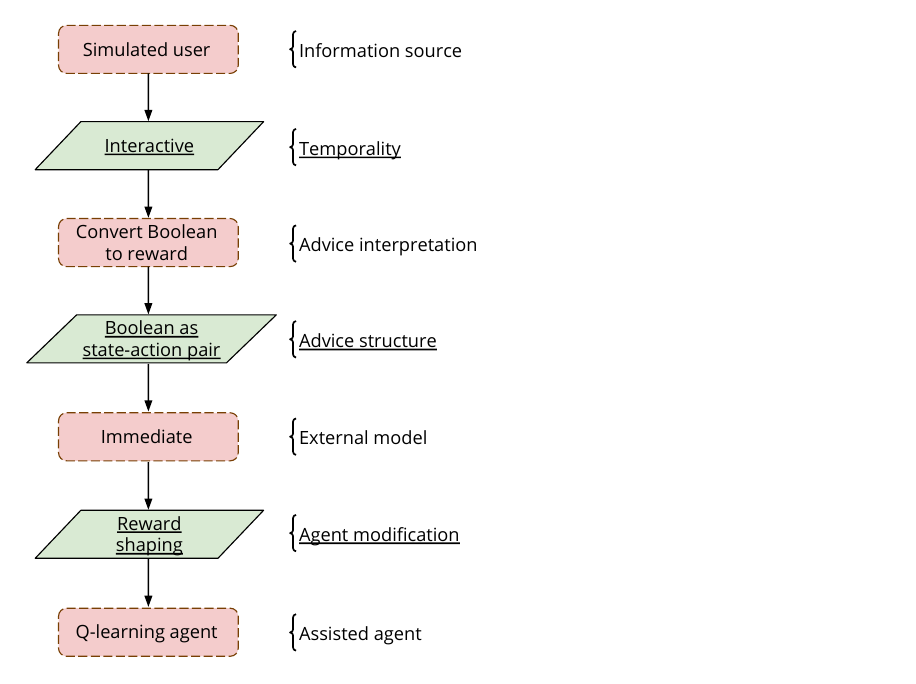
Figure 4. Definition of the evaluative interactive reinforcement learning approach using the assisted reinforcement learning framework [8]. Processing components are displayed in red squares and communication links in green